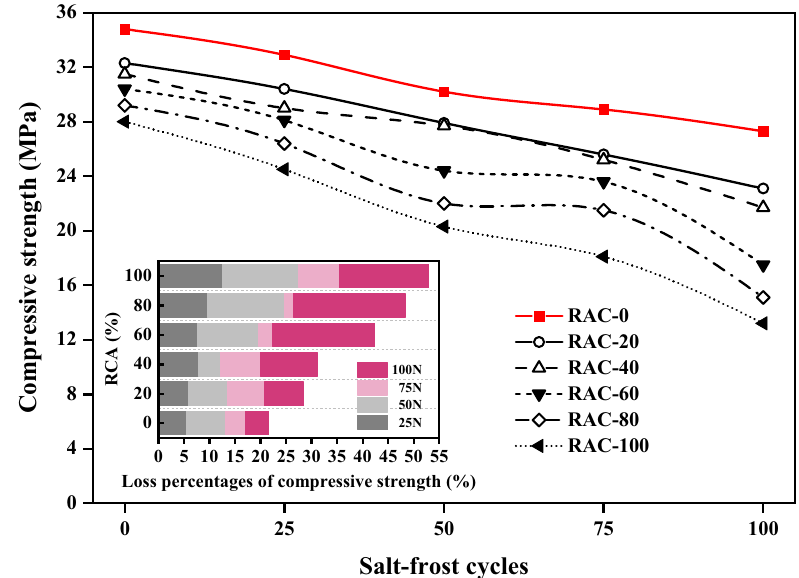
Figure 7: The compressive strength of concrete after salt - frost